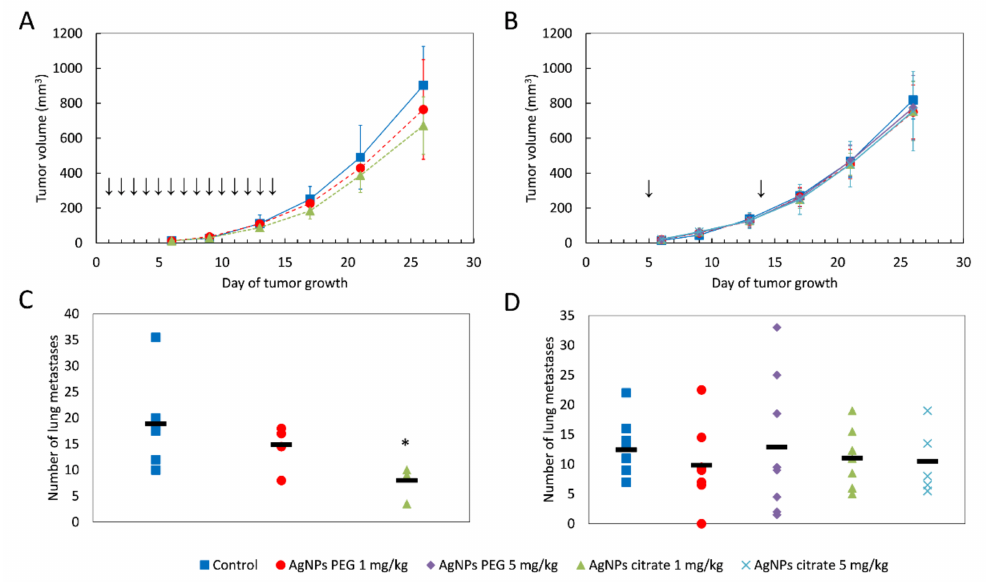
Figure 1. Tumor volume and the number of lung metastases in mice treated intragastrically ( A , C ) or intravenously ( B , D ) with citrate- or PEG-coated AgNPs. In A and B, data are presented as the mean ± standard deviation and arrows indicate the day of AgNPs administration. In C and D, the black rectangle represents the mean and the markers represent data from individual mice. * p < 0.05, n = 6.